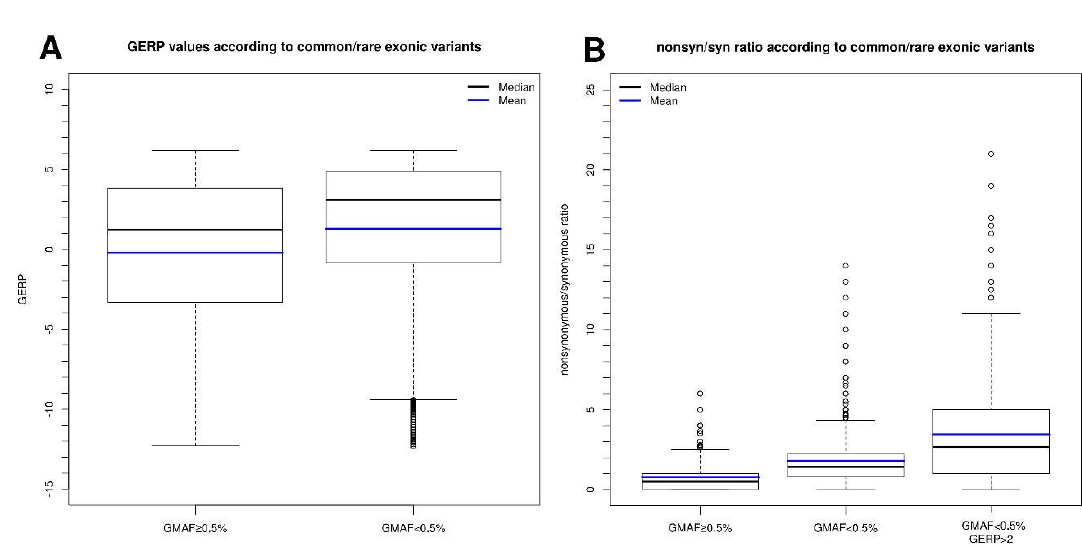
Figure 4. ( A ) Boxplot of GERP (Genomic Evolutionary Rate Profiling) values according to common (GMAF > 0.5%) and rare (GMAF < 0.5%) exonic variants. ( B ) Boxplot of non- synonymous/synonymous ratio values of each gene according to: common (GMAF > 0.5%), rare (GMAF < 0.5%), and highly conserved rare variants (GMAF < 0.5%, GERP >